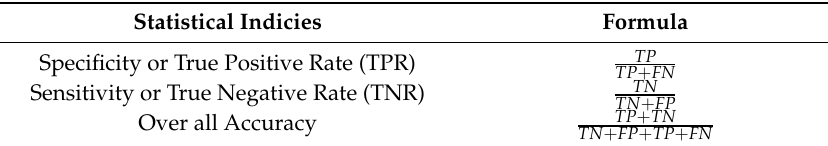
Table 1. Staistical indices usd in this study.